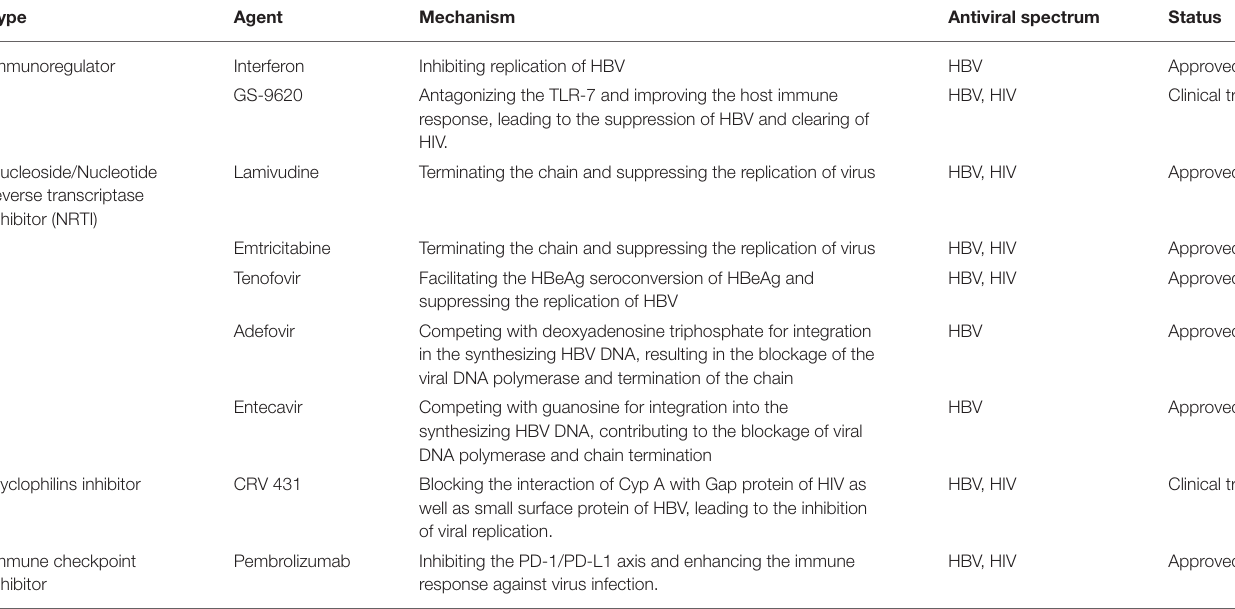
TABLE 1 | Antiviral agents applicated in HBV/HIV coinfection. Type Agent